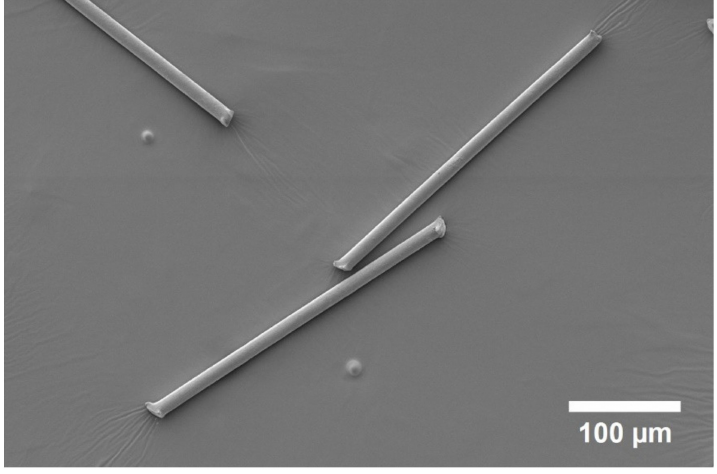
Figure 1. Scanning electron microscopy image of the polyamide 6.6 fibers (0.3 mm, 1.7 dtex) showing highly size-uniform and straight